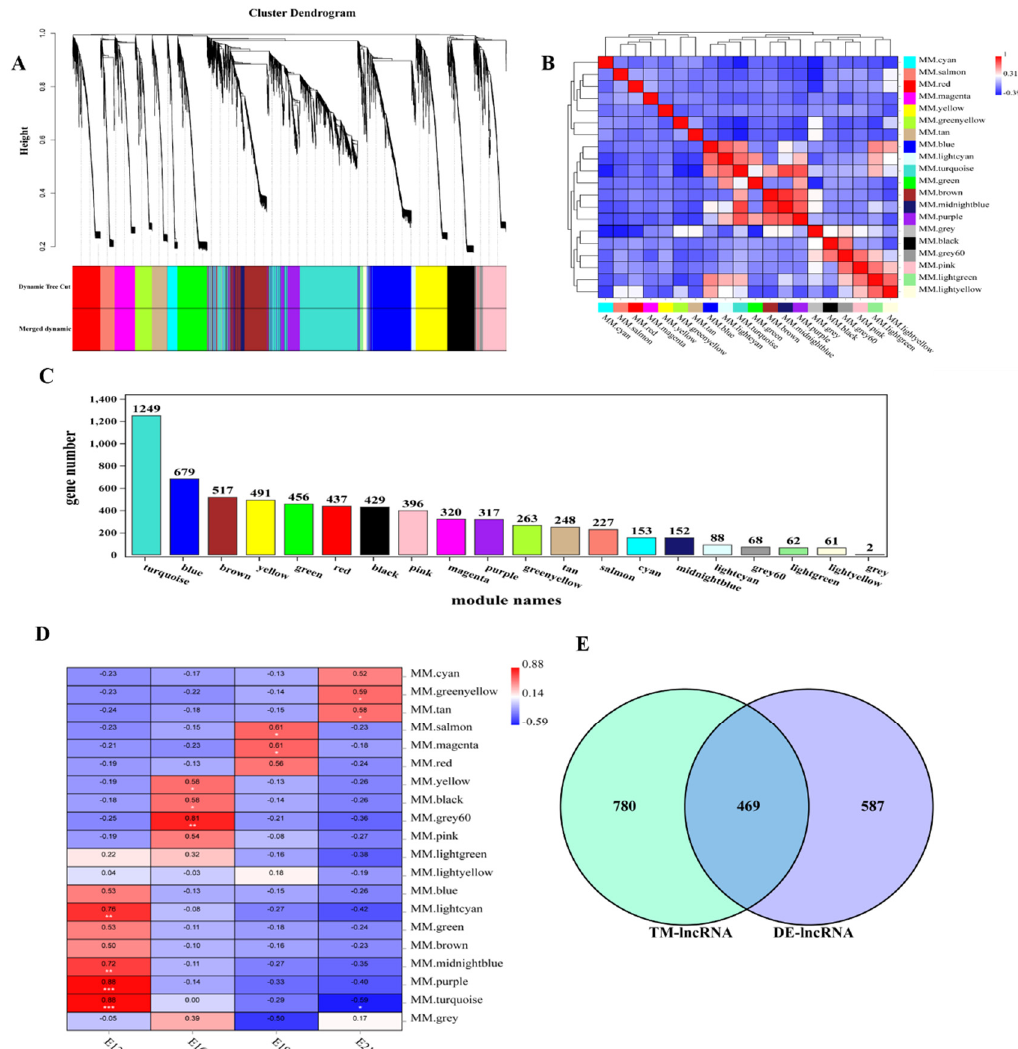
Figure 3. Weighted gene co − expression network analysis of lncRNAs. ( A ) Module eigenvalue clustering; ( B ) correlation analysis of modules; ( C ) lncRNA statistics of each module. Different colors of the axes represent different modules, respectively; ( D ) trait correlation analysis; ( E ) the differential expression gene screening from E12 module.